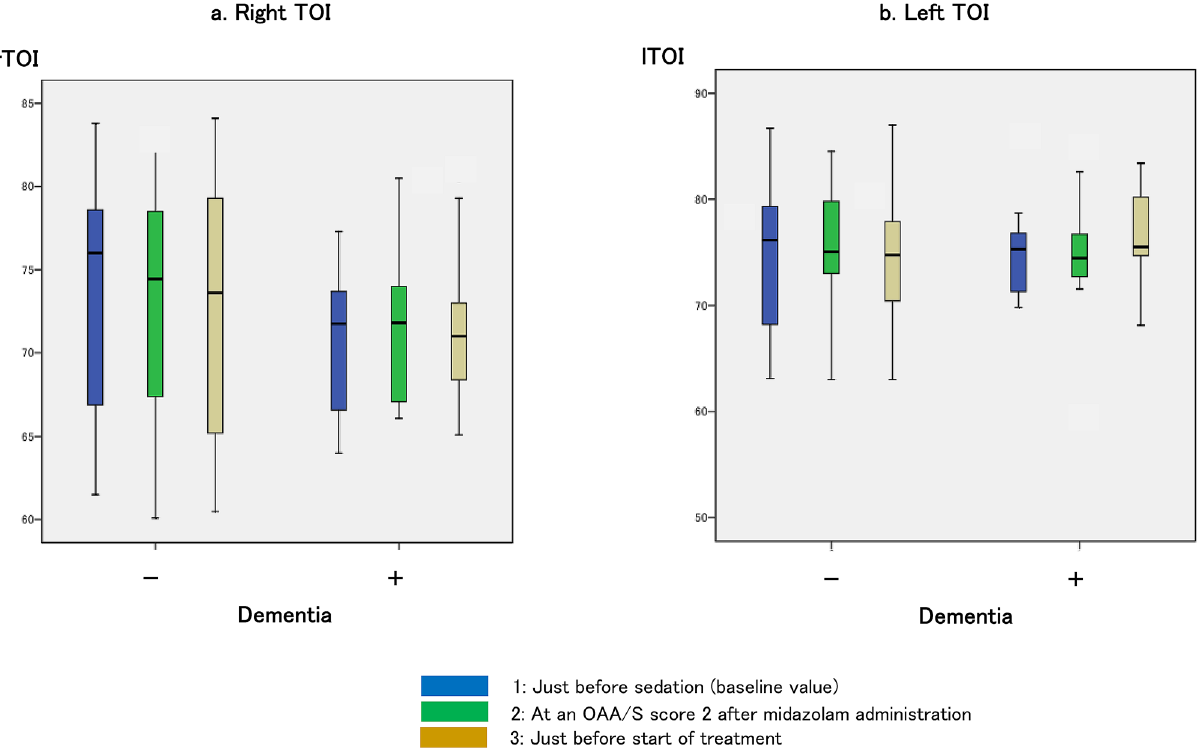
Figure 6. Changes in the tissue oxygenation index (TOI). ( a ) indicates the right TOI values: 76.0% (66.4–79.7) just before sedation (baseline value), 74.5% (66.9–79.5) when OAA/S score of 2 was achieved after midazolam administration, and 73.6% (65–79.6) just before the start of treatment in the dementia-negative group; 71.8% (66.4–74.4) just before sedation (baseline value), 71.8% (66.9–74.5) when OAA/S score of 2 was achieved after midazolam administration, and 71.0% (67.8–74.6) just before the start of treatment in the dementia-positive group. ( b ) indicates the left TOI values: 76.2% (67.1–80.9) just before sedation (baseline value), 75.1% (70.7– 80.9) when OAA/S score of 2 was achieved after midazolam administration, and 74.8% (68.6–79.5) just before the start of treatment in the dementia-negative group; 75.3% (71.2–77.3) just before sedation (baseline value), 74.5% (72.4–78.2) when OAA/S score of 2 was achieved after midazolam administration, and 75.5% (74.4–80.6) just before the start of treatment in the dementia-positive group. Independent